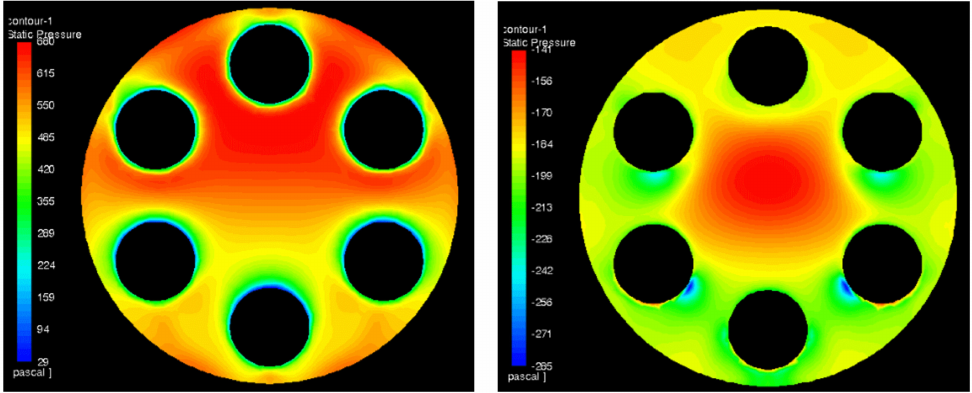
Figure 24. Pressure drop distribution for the case with the obstacle on the upstream ( left ) and downstream ( right ) side of